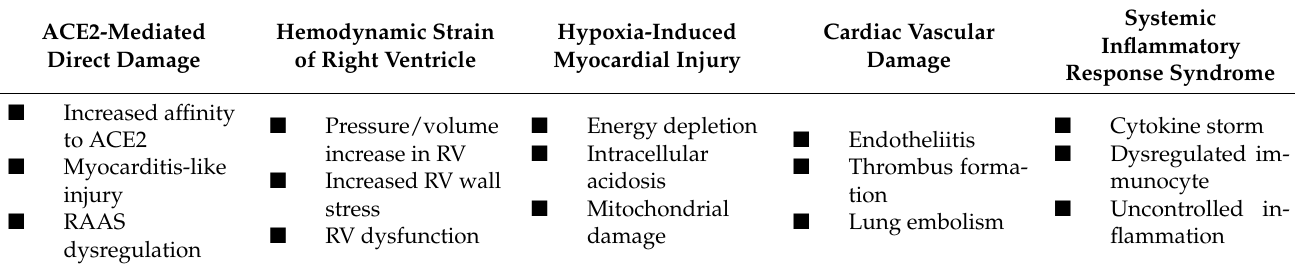
Table 2. Potential direct and indirect mechanisms of SARS-CoV-2-mediated myocardial injury (modified according to Kurz et al.